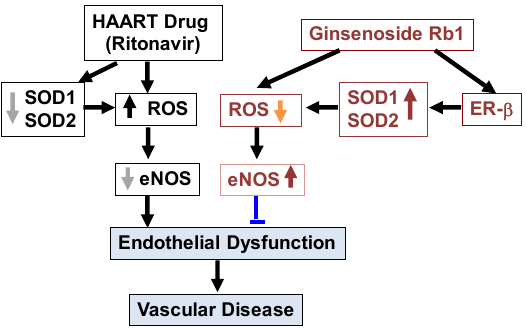
Figure 9. Conclusion of the current study. The current study demonstrates that ritonavir (RTV), an HAART drug, can cause oxidative stress and endothelial dysfunction by increase of ROS production and decrease of expression of SOD1, SOD2 and eNOS in human endothelial cells. Thus, RTV-induced oxidative stress and endothelial dysfunction could contribute to cardiovascular disease. On the other hand, ginsenoside Rb1 can effectively block the effects of RTV via a unique mechanism by which Rb1 specifically binds to and activates ER-β and induces upregulation of SOD1, SOD2 and eNOS in human endothelial cells. Rb1 can also directly scavenge ROS.